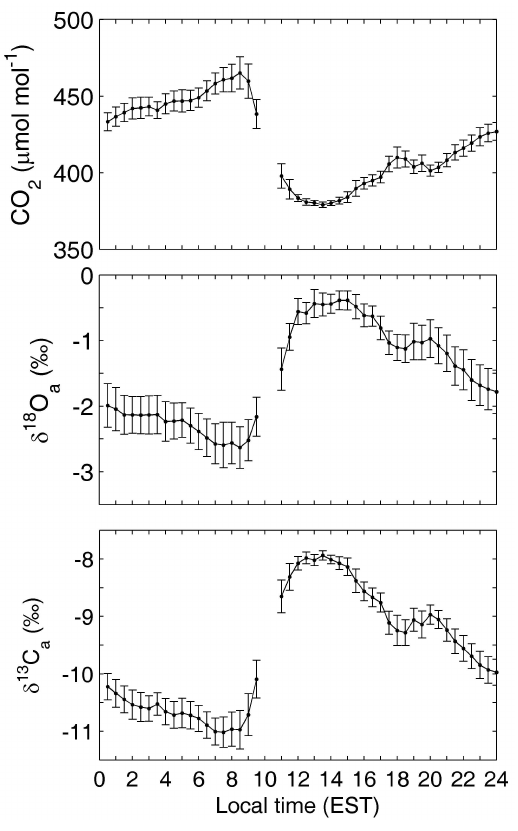
Fig. 5. Ensemble half-hourly average of CO 2 mixing ratio and iso- topic compositions of CO 2 ( δ 18 O a and δ 13 C a , VPDB scale) in the air at 1.45m above the floor of a deciduous temperate forest from day of the year 188 to 274 in 2009. The error bars indicate ± 1 mean standard error. Data from 10:00 to 11:00h (EST) were dis- carded due to liquid nitrogen filling time, which resulted in fewer data points than the remaining hours of the day.